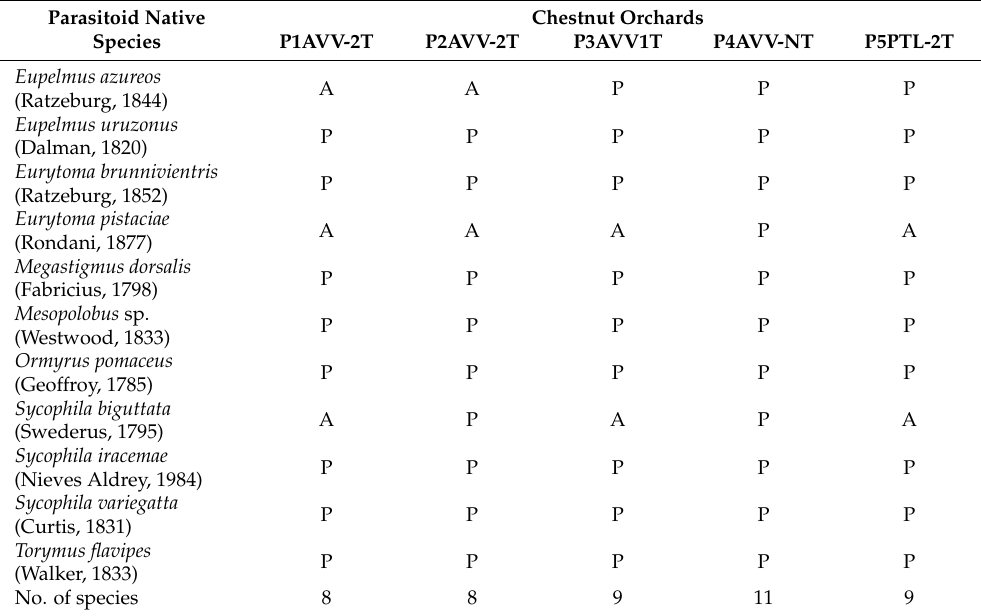
Table 7. Systematic position of parasitoid species identified in chestnut orchards located in Arcos de Valdevez and Ponte de Lima in 2018. Species Family E. azureos E. urozonus Mesopolobus